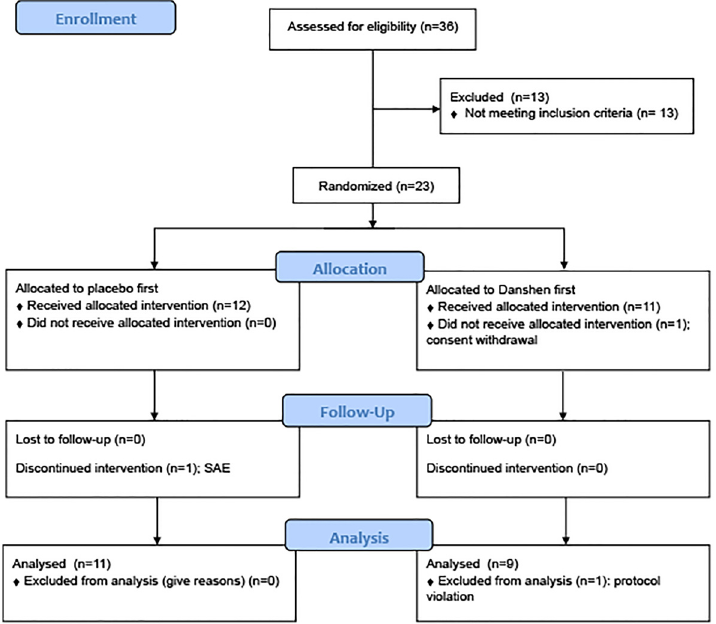
Fig 1. CONSORT flow diagram. SAE: Serious Adverse Event. The SAE (Bell ’ s palsy) occurred during Danshen treatment (see text).